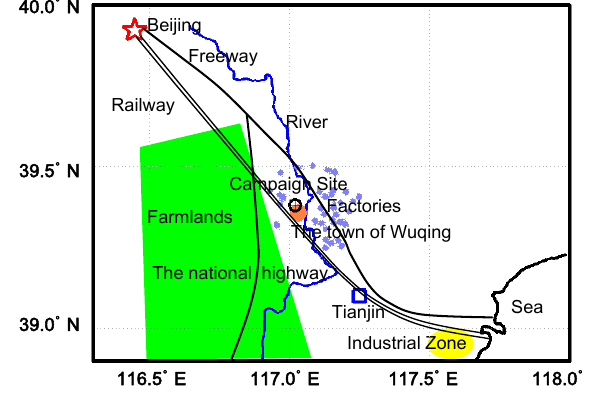
Fig. 1. A sketch of the campaign site and its